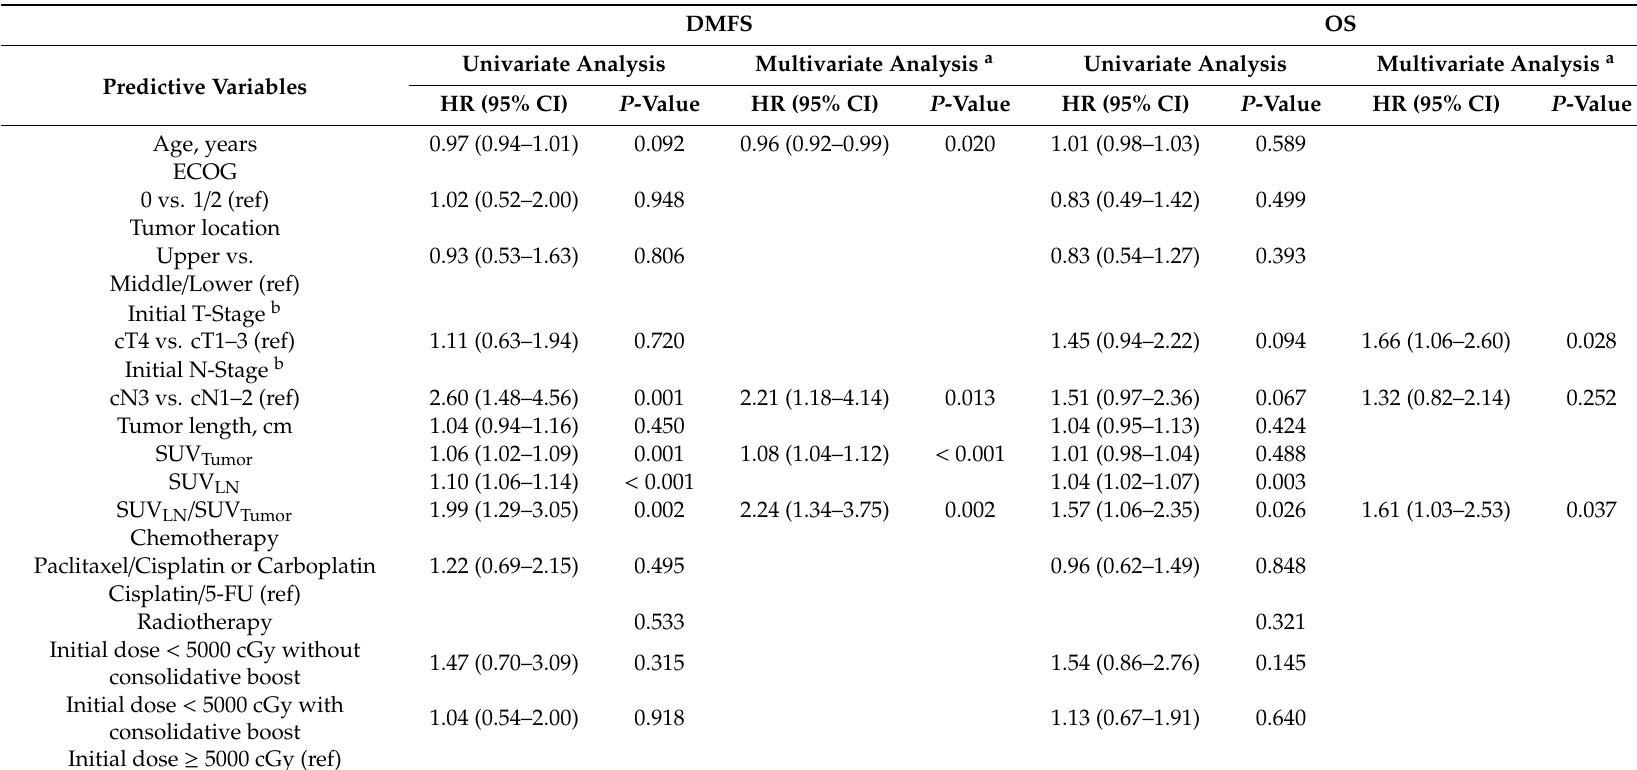
Table 3. Univariate and multivariate analysis of risk factors associated with DMFS and OS in ESCC patients treated with dCRT. DMFS OS Univariate Analysis Multivariate Analysis a Univariate Analysis Multivariate Analysis Predictive Variables